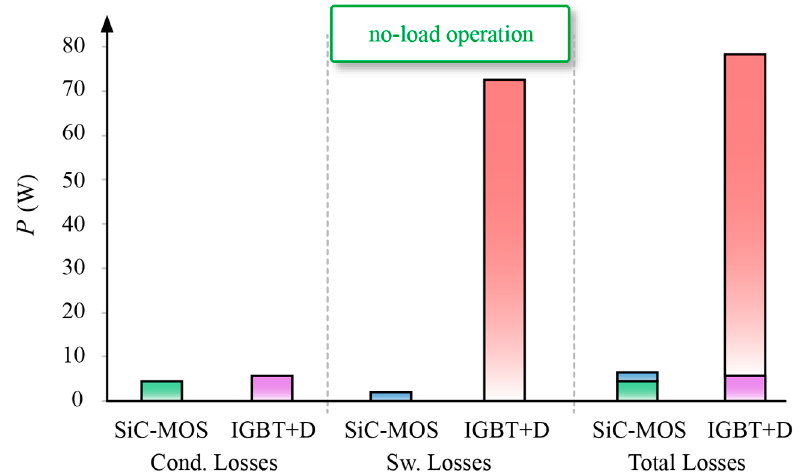
Figure 12. Comparison of conduction and switching losses of light-load SiC MOSFET and high-power IGBT modules under no-load condition.